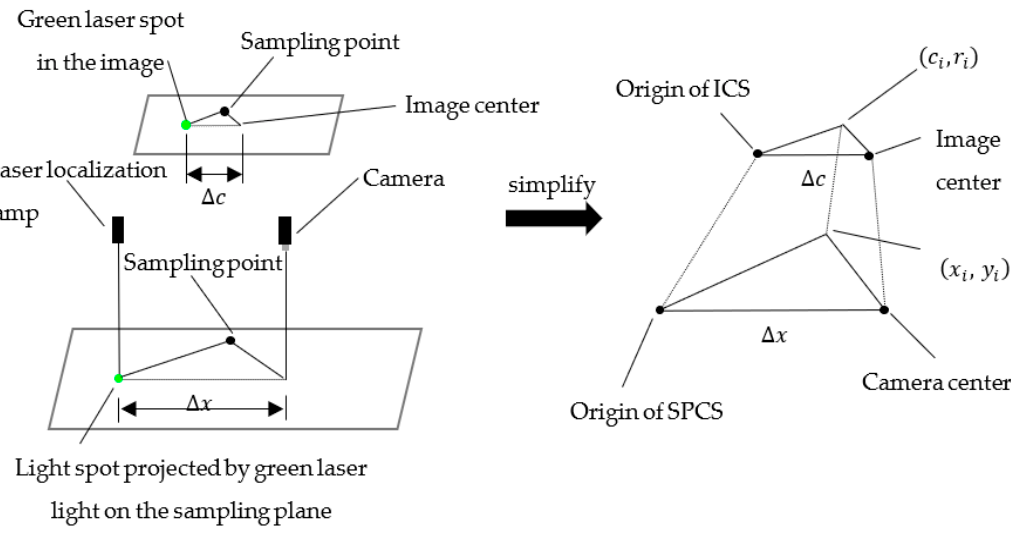
Figure 23. Coordinate conversion schematic.